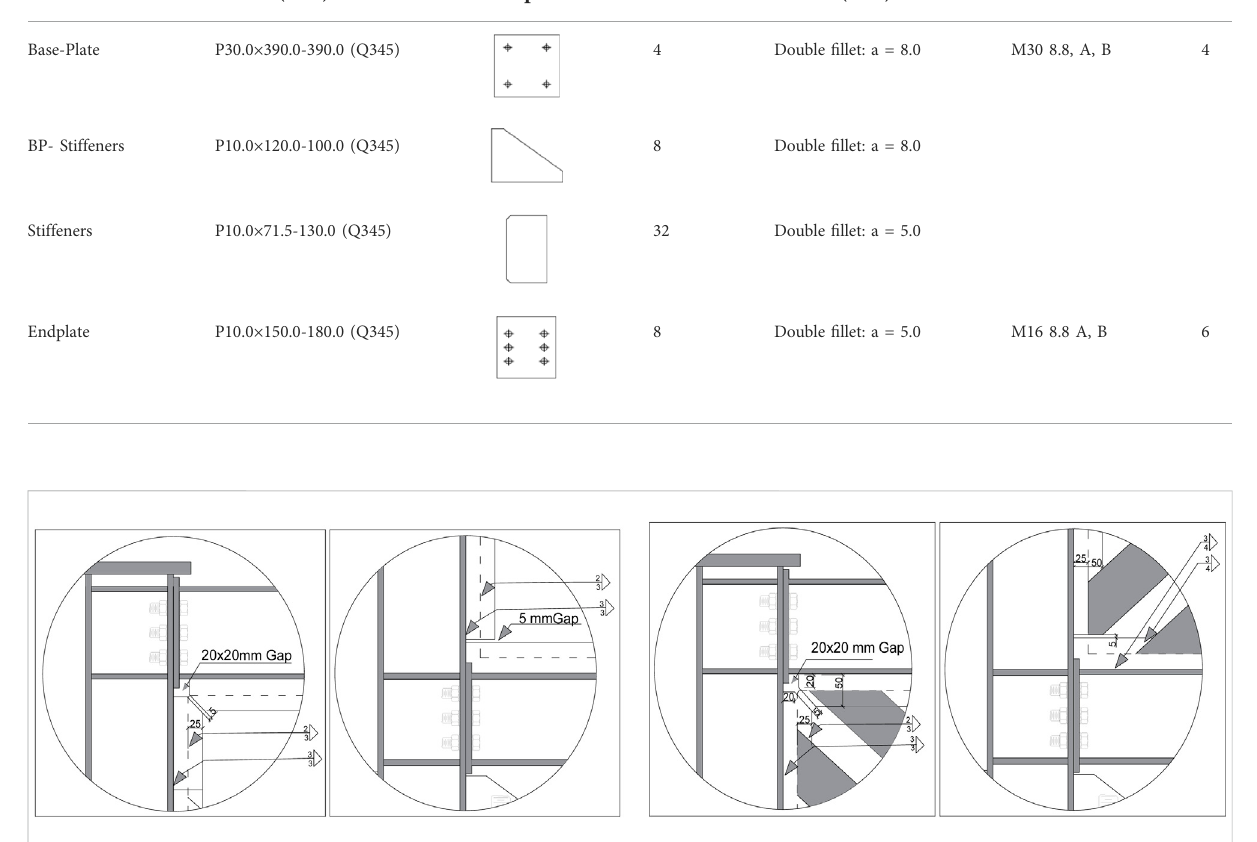
FIGURE 3 Connection details of web plates and in fi ll web strips to beam columns (unit: